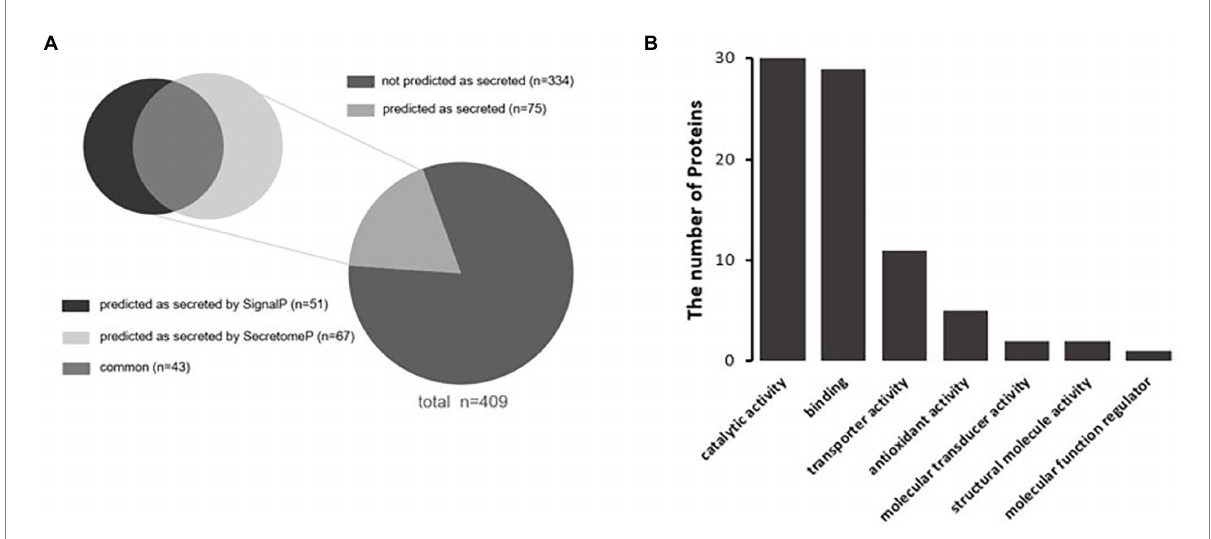
FIGURE 3 (A) Prediction of secreted proteins among Salmonella proteins with significant changes in abundance within extracellular vesicles. SecretomeP was used for ab-initio predictions of non-classical (i.e., not signal peptide mediated) protein secretion, and SignalP was used for predictions of secreted proteins with N-terminal signal peptides. (B) Functional classification of secretory proteins by GO